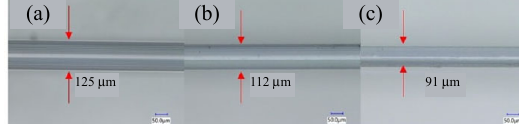
Fig. 5 Different diameter of PCF under the microscope.